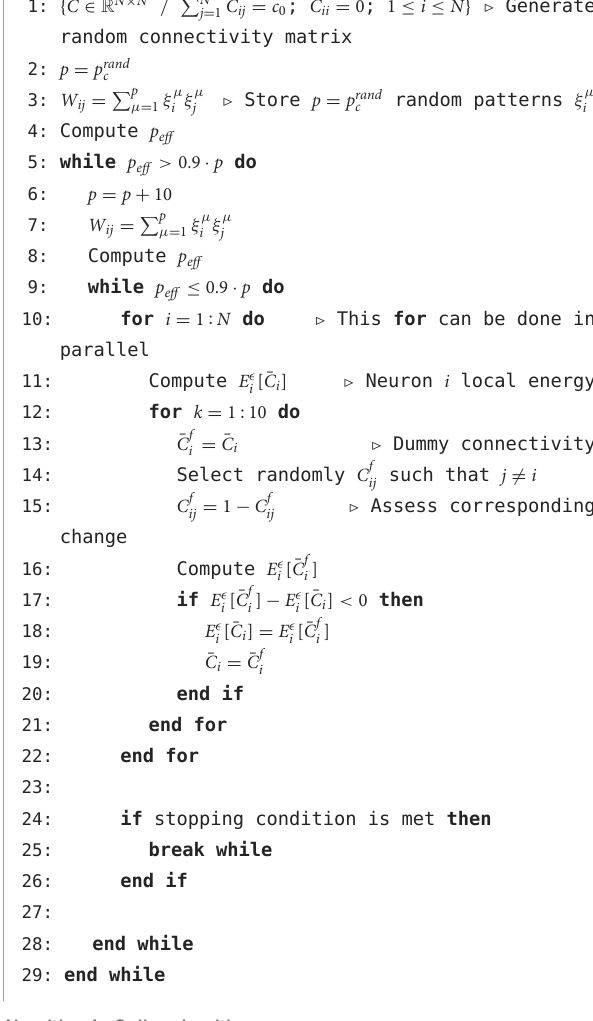
Algorithm 1. Online